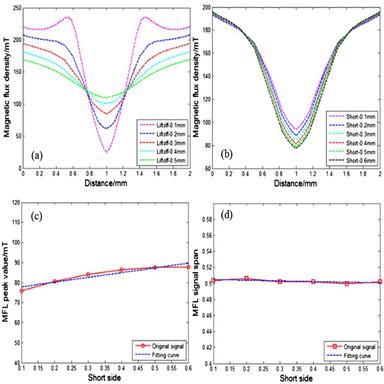
MFL signals and characterizations of trapezoid defect; (a) MFL signals of trapezoid defect in different liftoff values with the short side length of 0.3 mm; (b) MFL signals of trapezoid defect in different short side lengths with the liftoff of 0.3 mm; (c) Relationships between MFL peak values in (b) and short side lengths; (d) Relationships between MFL signal spans in (b) and short side lengths.